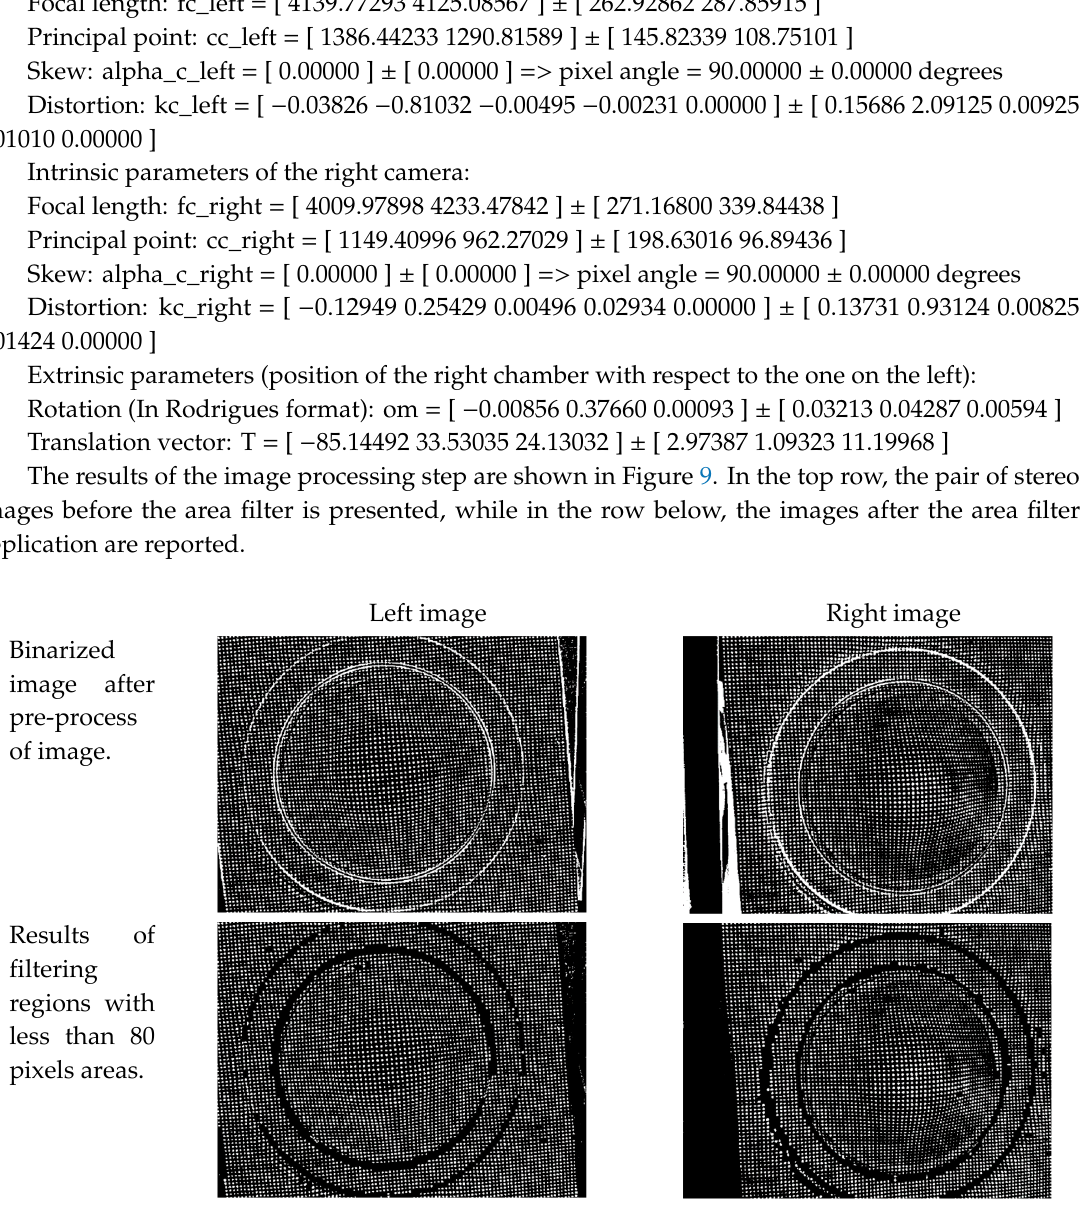
Figure 8. Image segmentation to obtain referential ellipses for the deformation measurement. Figure 9. Image segmentation to obtain referential ellipses for the deformation